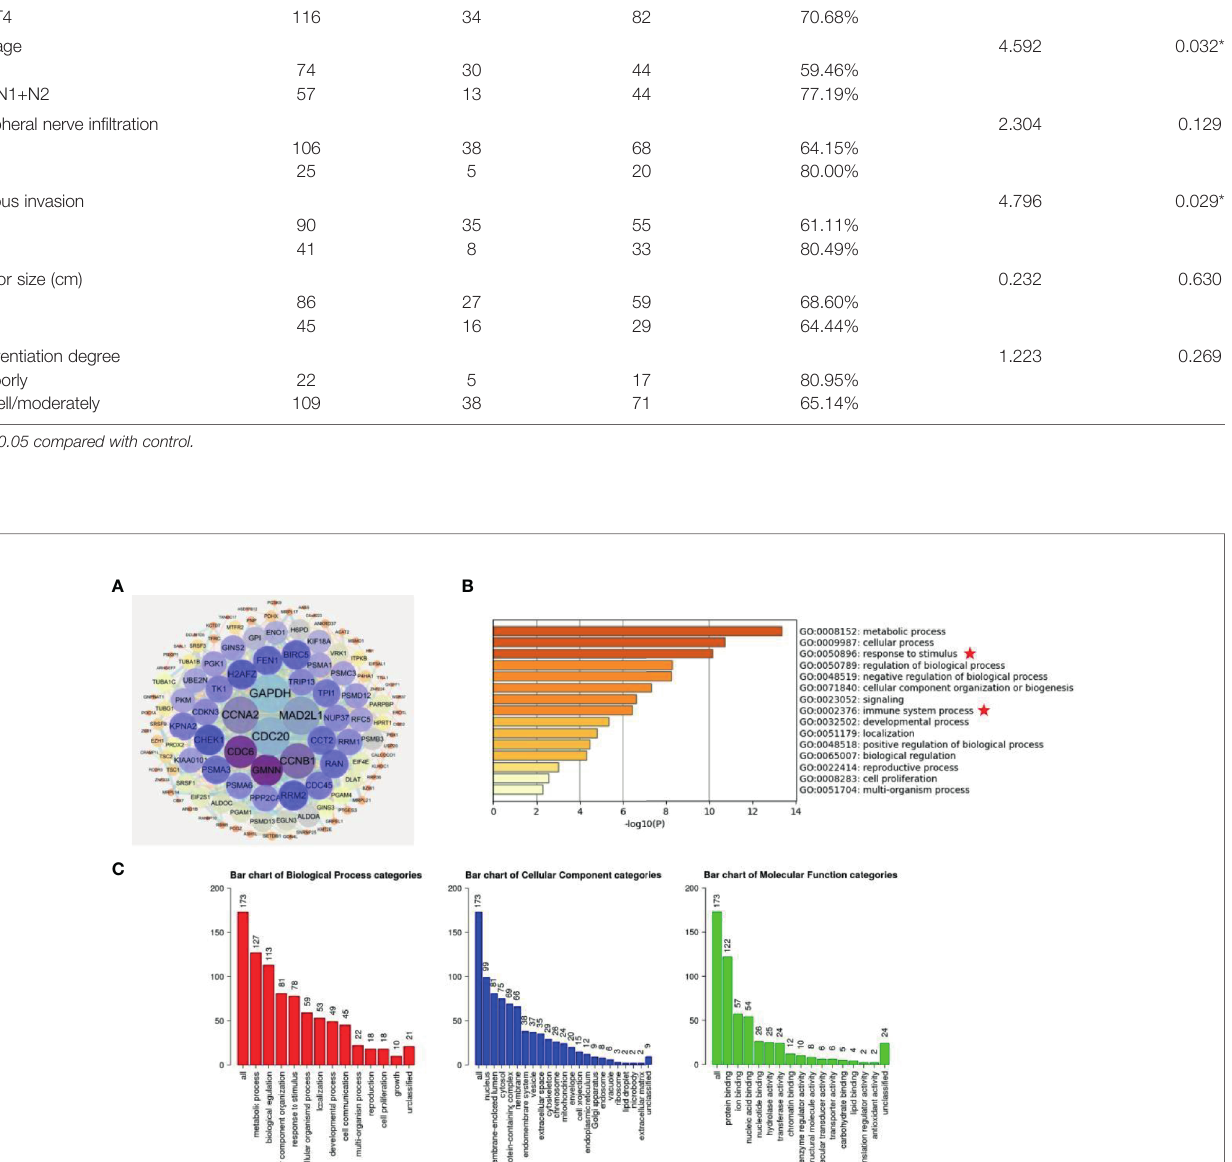
Frontiers in Oncology |